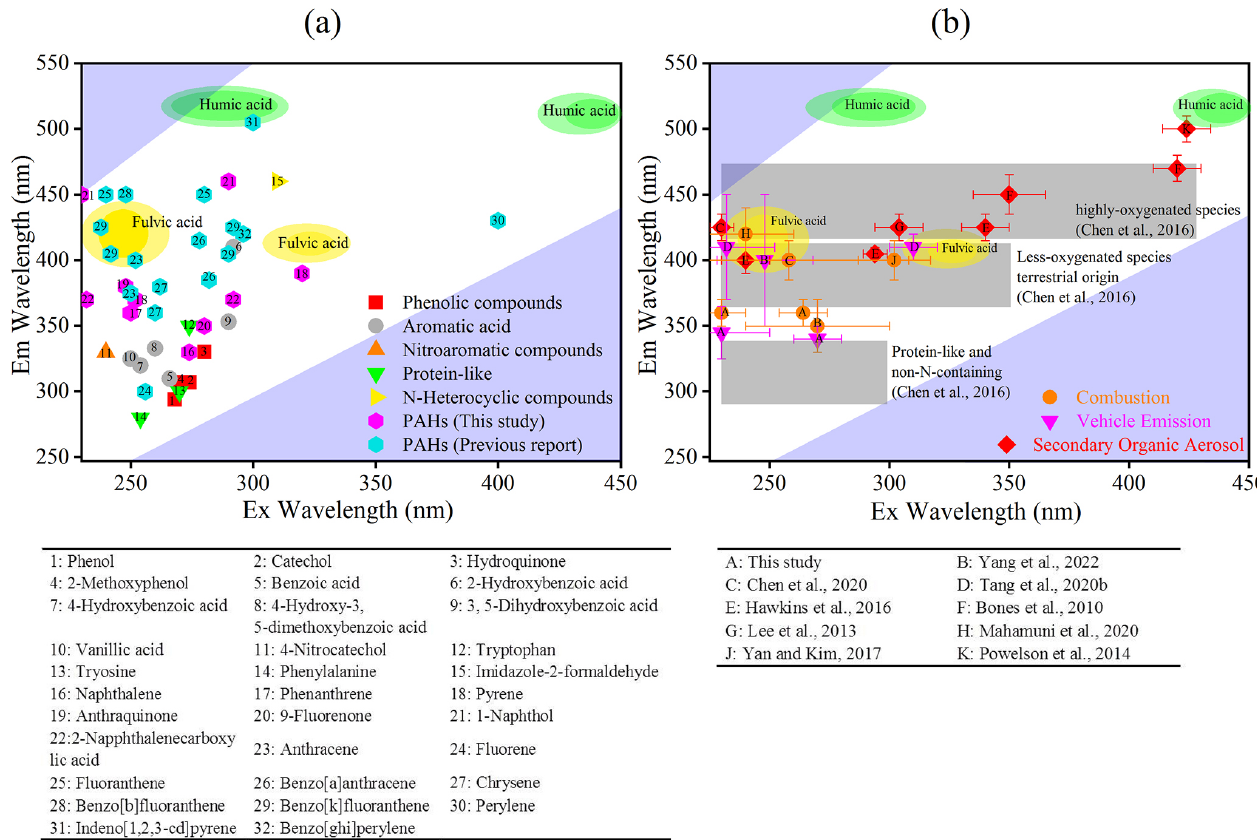
Figure 1. Comparison of the chemical characteristics of molecules assigned to each fluorescence component of BrC model compounds (a) and source WSOM (b)